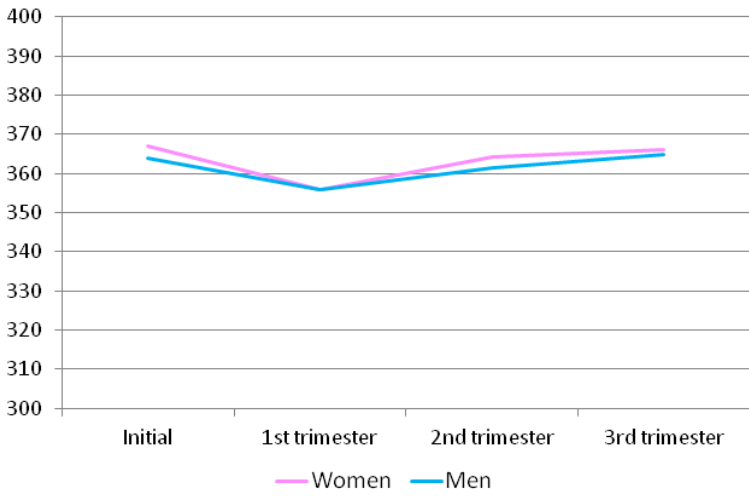
Figure 1. Total test scores of the men and women at different time points throughout pregnancy. Table 6. Comparison by sex of the test domain scores and the total